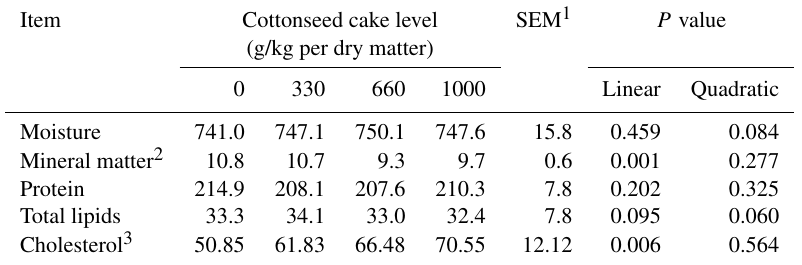
Table 6. Centesimal composition (g/kg) and cholesterol content (mg/100g of meat) of the longissimus lumborum muscle of feedlot goats fed diets containing cottonseed cake replacing soybean meal.